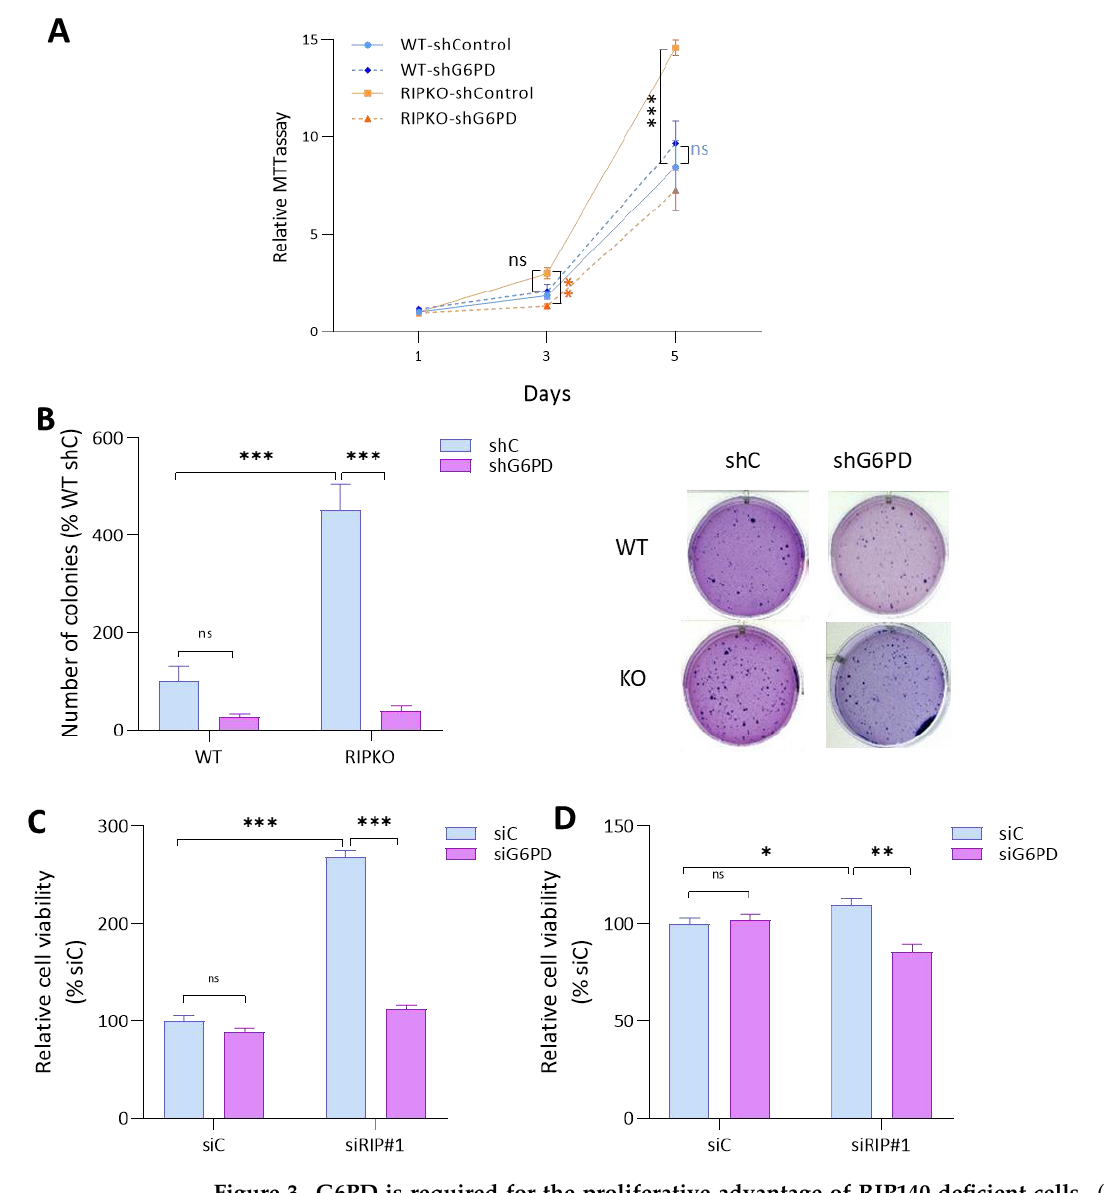
Figure 3. G6PD is required for the proliferative advantage of RIP140-deficient cells. ( A ) 3-(4,5- dimethylthiazol-2-yl)-2,5-diphenyltetrazolium bromide (MTT) assay in WT or RIPKO MEFs trans- fected with shRNA control or shG6PD expression lentivirus. The data are normalized to day 1 values for each shRNA and to WT control shRNA. Blue asterisks correspond to differences between WT samples, orange ones to differences between KO samples, and black ones to differences between WT and KO samples. ( B ) Number of colonies from a colony formation in soft-agar assay of transformed MEF WT or RIPKO transfected with shRNA control or G6PD expression lentivirus. The data are expressed as percentages of WT shControl samples (shC) (left panel). Pictures of colonies in soft agar stained by crystal violet (right panel). ( C , D ) Cell viability assessed by crystal violet staining of MDA-MB-436 cells ( C ) and MCF7 cells ( D ) transfected with RIP140 siRNA (siRIP) combined with G6PD siRNA. The data are normalized to day 1 values for each siRNA and then to control siRNA (siC) samples representing the growth advantage of siRIP140 transfected cells over siC cells. All experiments were conducted at least three times. Values are means ± SEM; * p < 0.05, ** p < 0.01, *** p < 0.001, ns = not significant.